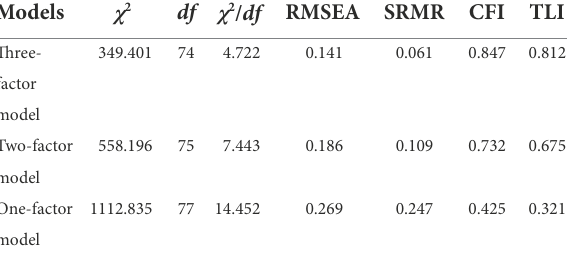
TABLE 5 The goodness of fit metrics for the three candidate models ( N = 186). Models